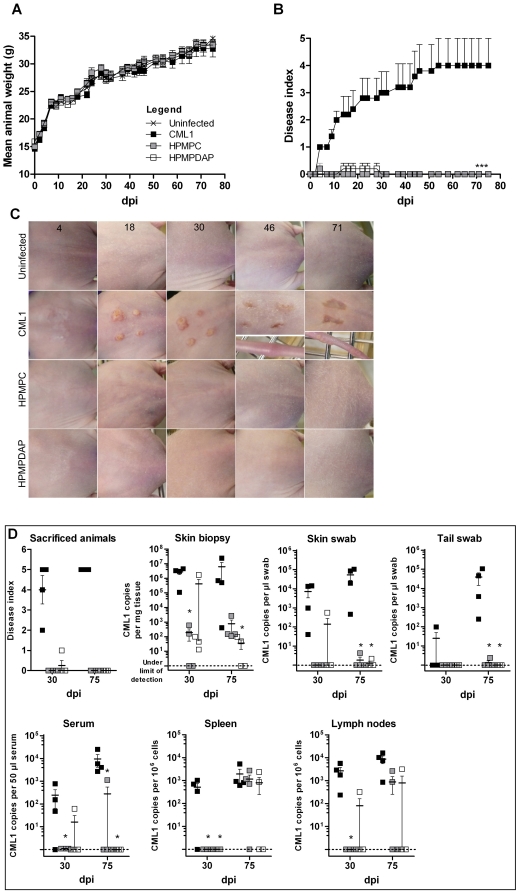
Effects of topical HPMPC and HPMPDAP against CML1 propagation in cutaneously infected nu/nu mice.Animals were scarified with PBS (uninfected group) or with CML1 at a dose of 2.0×106 PFU (CML1, HPMPC and HPMPDAP groups). Topical application of 1% HPMPC- and HPMPDAP-cream started the day of infection for 5 days, once per day. Uninfected and CML1 groups were treated similarly with a placebo-cream. Animals were monitored for 75 days for body weight (A, n = 5), lesions development (B–C), and viral loads (D). B; Disease indices or scores were given as stated in materials and methods. Data are mean±SEM (n = 5). C; photos were taken at 4, 18, 30, 46 and 75 dpi, and show the evolution of the primary lesions and their spread to the tail. D; the disease index of the sacrificed mice (n = 4 per group) is shown. Viral loads in various tissues and swabs were determined by qPCR at days 30 and 75 post-infection. Data are mean±SEM. For statistical analyses, see materials and methods. Results are representative of two independent experiments.